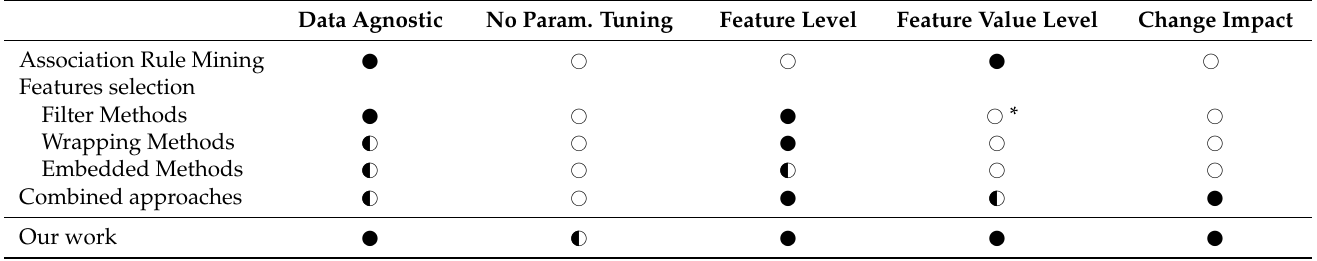
Table 9. Comparison of the related work with respect to the desiderata for bias detection presented in Section 2, where means “support”, “partially support”, “no support”. The asterisk (‘*’) (cid:32) (cid:71)(cid:35) (cid:35) indicates that the requirement is only supported by some approaches. Data Agnostic No Param. Tuning Feature Level Feature Value